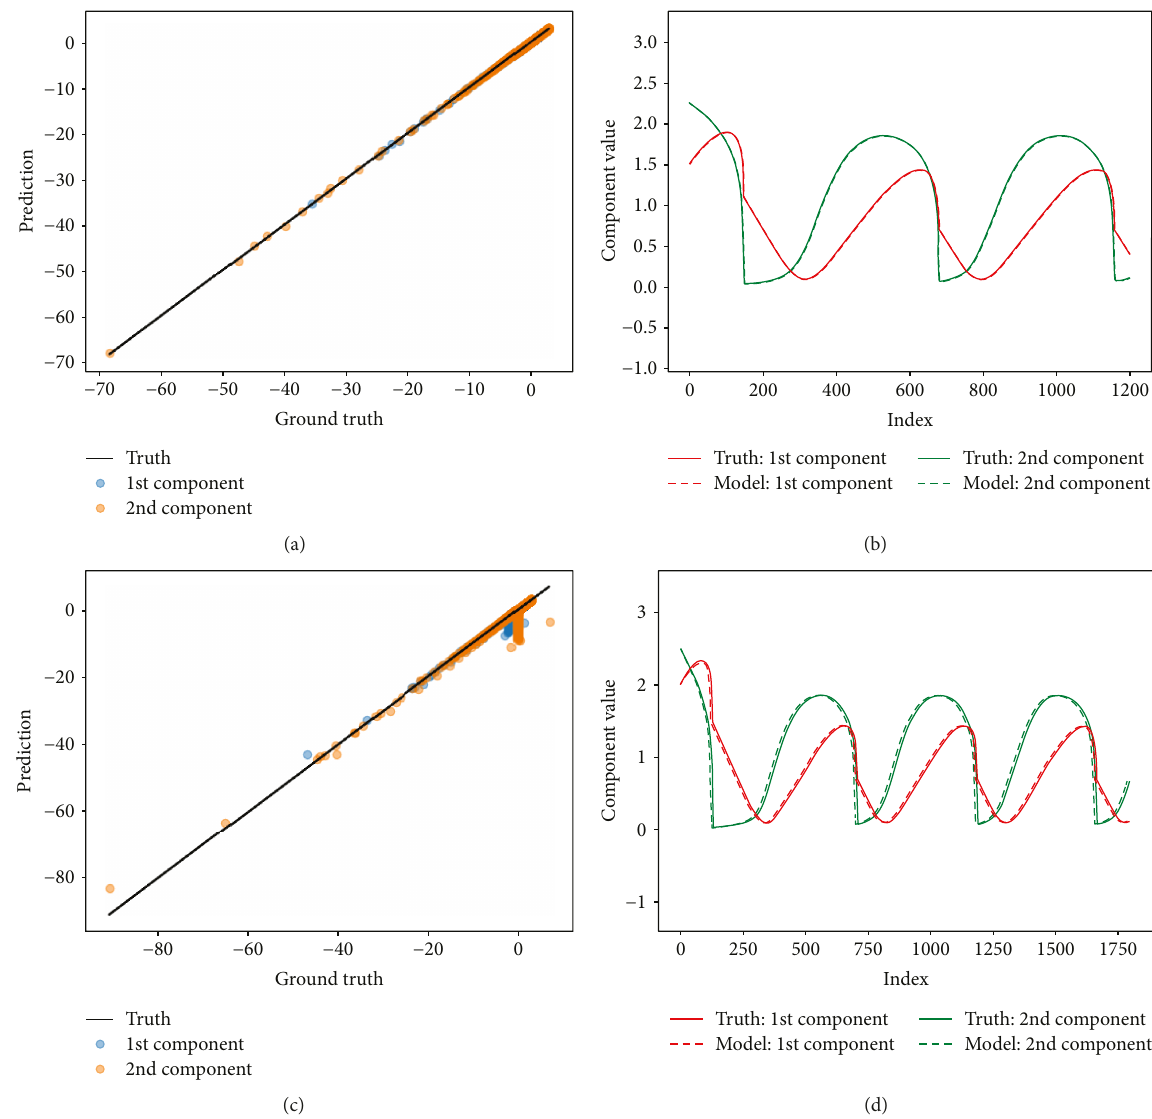
Figure 8: A priori and a posteriori result of the basic model on nonrational nonpolynomial case. (a, b) Training data. (c, d) Testing data. (a, c) A priori. (b, d) A